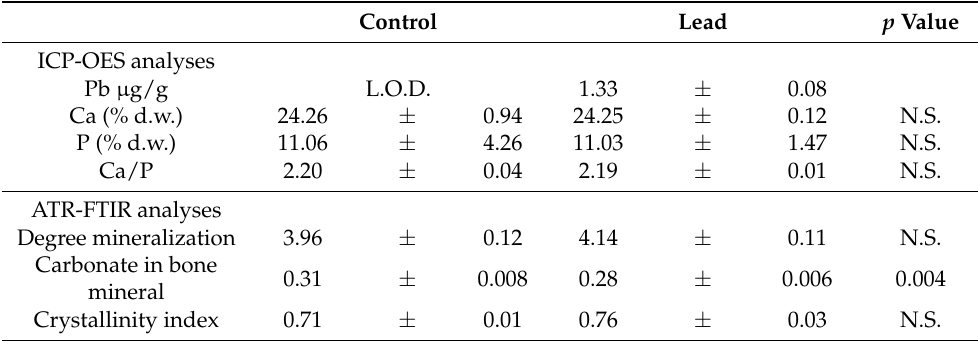
Table 3. Bone chemical parameters measured by ICP-OES and ATR-FTIR analyses of rat mandibles in the chronic lead exposure ( n = 8) and control groups ( n = 5). Values are expressed as means ± S.E.M (L.O.D. = limits of detection, N.S. = not